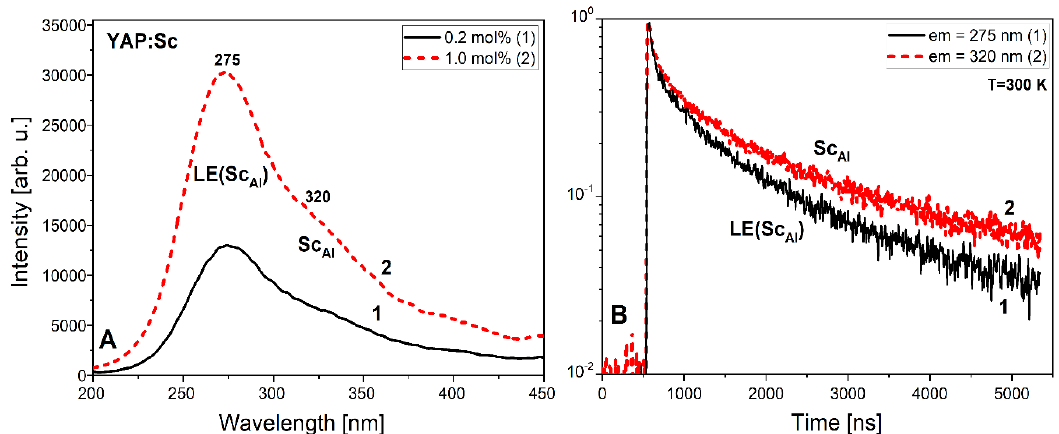
Figure 3. The CL emission spectra ( A ) of YAlO 3 :Sc 0.2 mol.% (1) and YAP:Sc 1.0 mol.% (2)